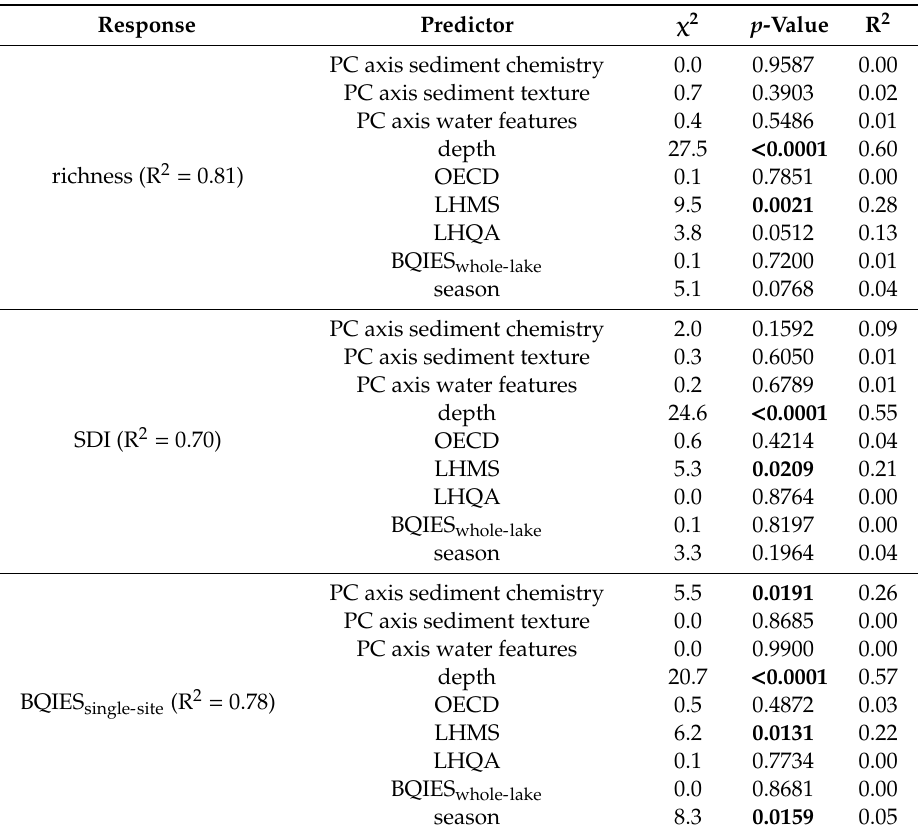
Table 4. Type II analysis of deviance tables as output of the GLMM assessing the e ff ect of sediment chemistry, sediment texture, water features and depth, including seasonality as a covariate, in addition to the metrics of overall lake quality (OECD, LHMS, LHQA and BQIES whole-lake ) and sites nested within each lake as random e ff ects, on three metrics of site biodiversity: richness, SDI (diversity) and BQIES single-site . Significant e ff ects are marked in bold. The model R 2 is reported for each model between parentheses after the name of the response